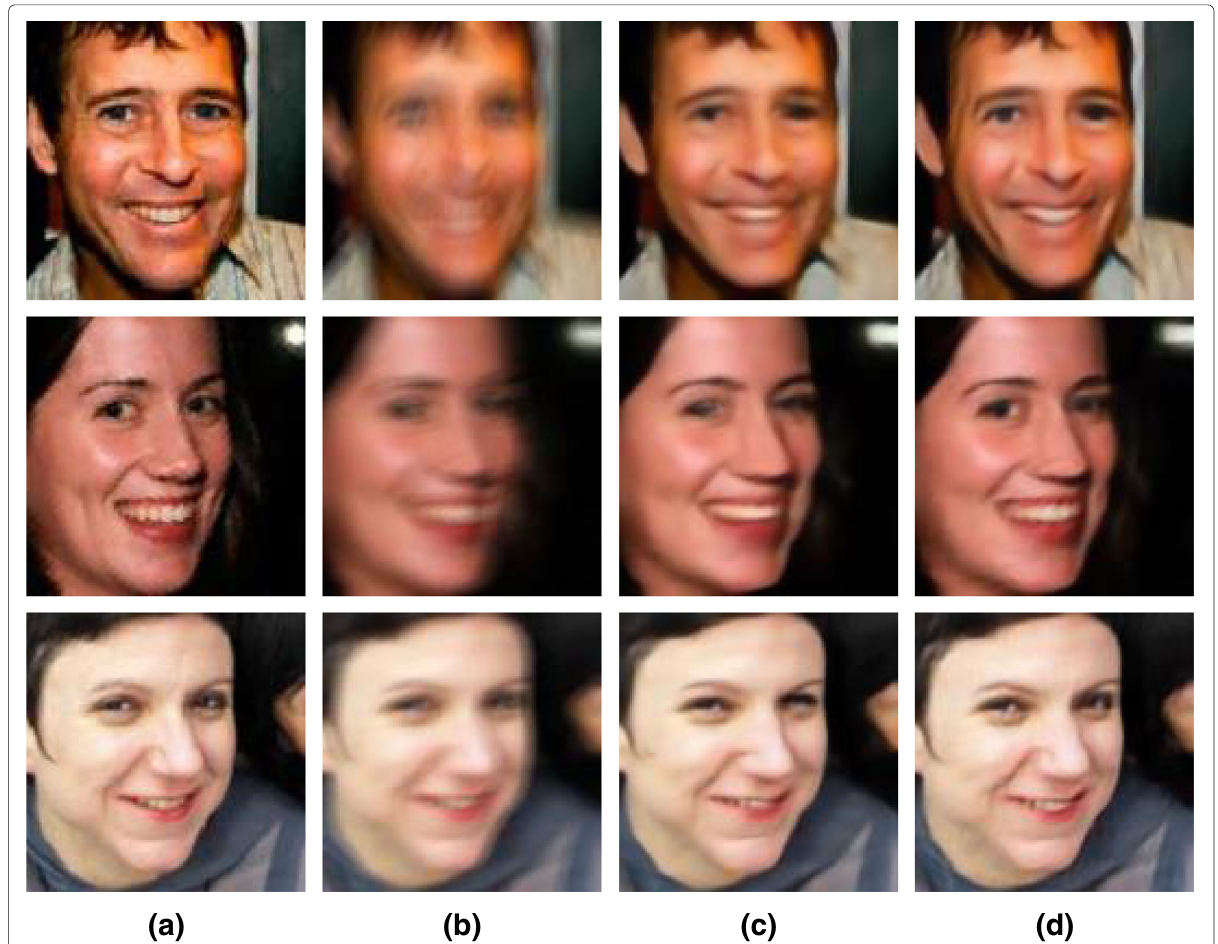
Fig. 4 Ablative study for transfer learning model. a Ground truth images. b Blurred images. c Deblurred results via a single-task model. d Deblurred result via a multi-task